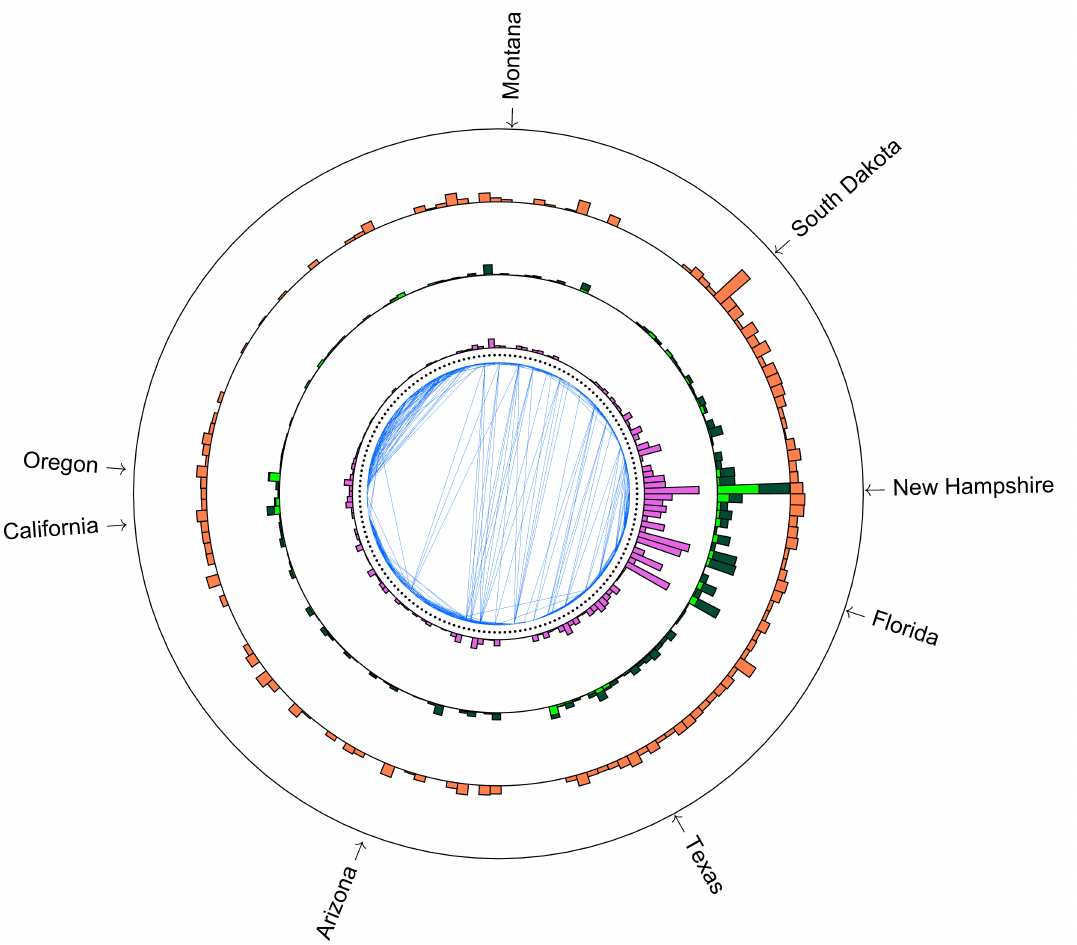
Figure 4. Status of power system in Year 0. The inner circle represents the transmission network, and the outer layers with purple, green, and orange bars represent demand, generation capacity, and fuel cost, respectively. Renewable and nonrenewable generation capacities are differentiated with light green and dark green colors,